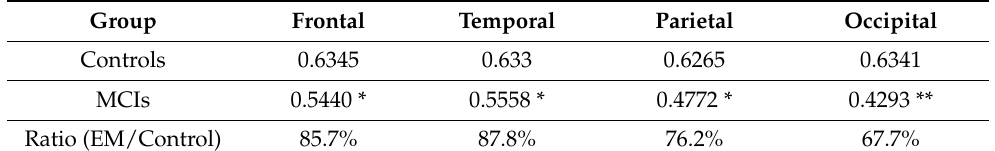
Table 8. The inter-lobular connectivity between the lobes of the control and MCI groups. * p < 0.05 and ** p < 0.01. Group Frontal